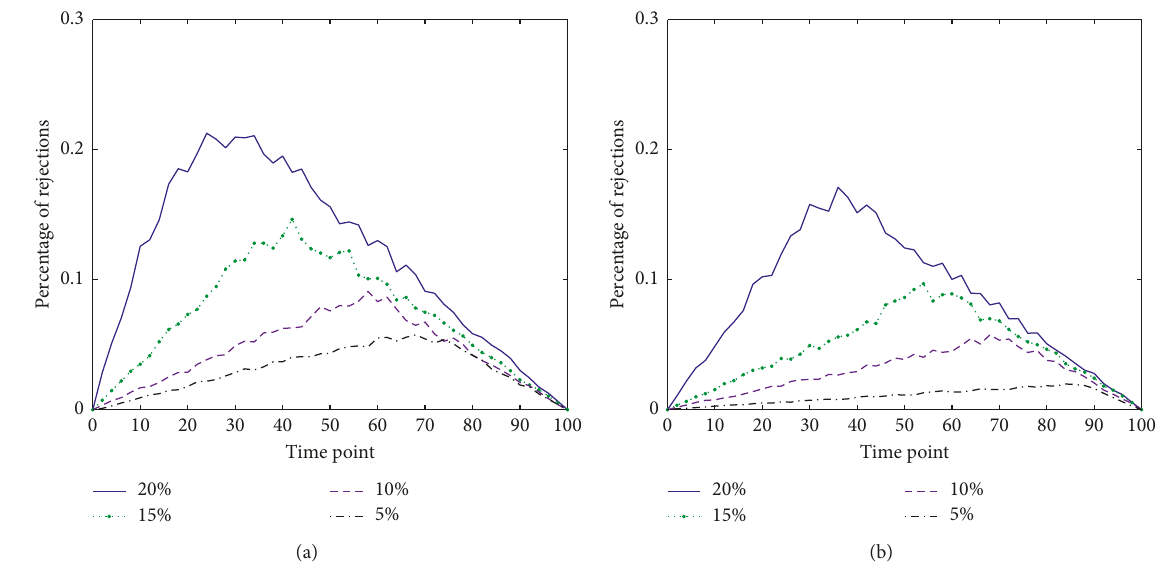
Figure 14: Percentage of rejections with initially infected ratio μ � 5% , 10% , 15%, and 20%: Haggle (a) and MT Reality